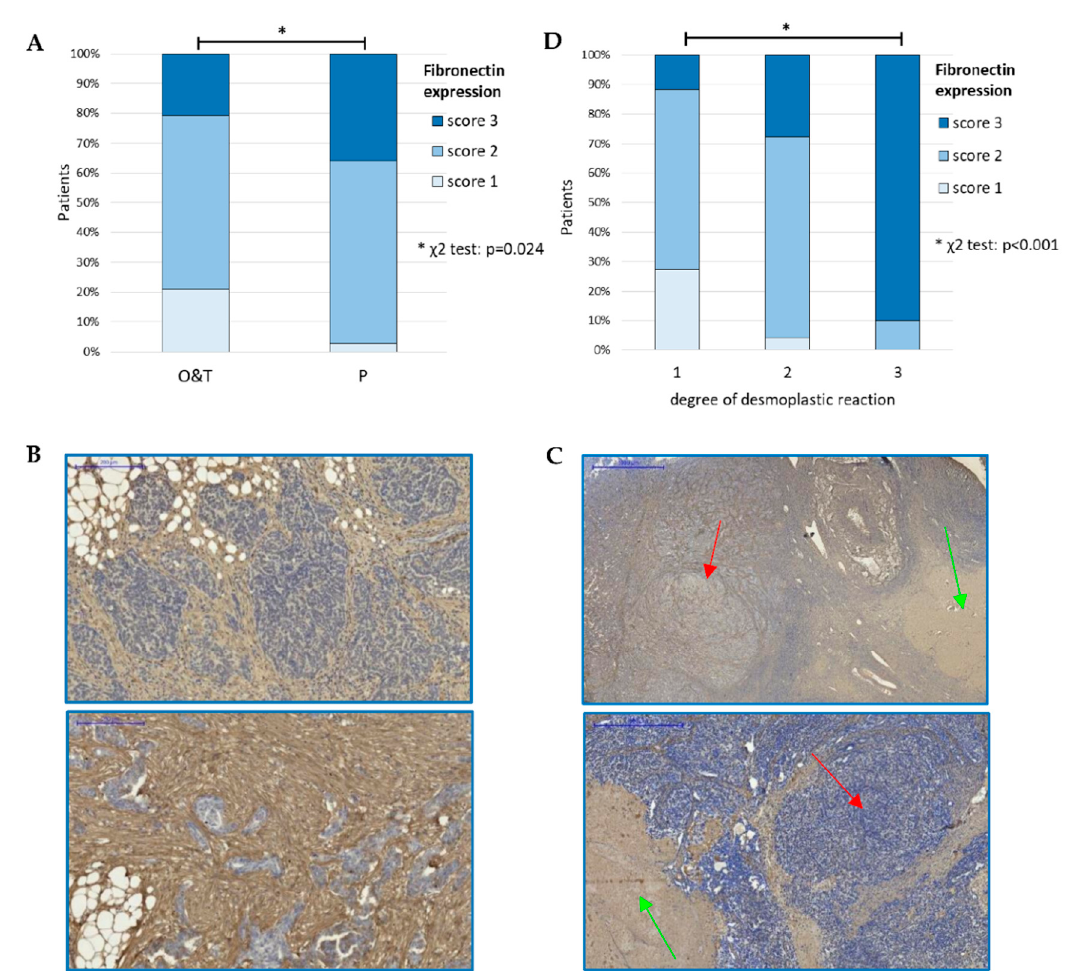
Figure 2. ( A ). Correlation between fibronectin expression and the anatomical source of tumor specimen ( χ 2 test, p = 0.024) p —samples derived from peritoneal/omental metastatic disease; O—primary tumors (samples containing visible ovarian structures); T—samples containing only tumor tissue; ( B ). Examples of specimens derived from omental metastatic disease (P) with strong fibronectin expression; ( C ). Examples of specimens containing ovarian structures (O), green arrows indicate whitish corpuscles, red arrows indicate nests of cancer cells; ( D ). Correlation between fibronectin expression and the degree of desmoplastic reaction ( χ 2 test, p < 0.001). *—denotes p < 0.05.